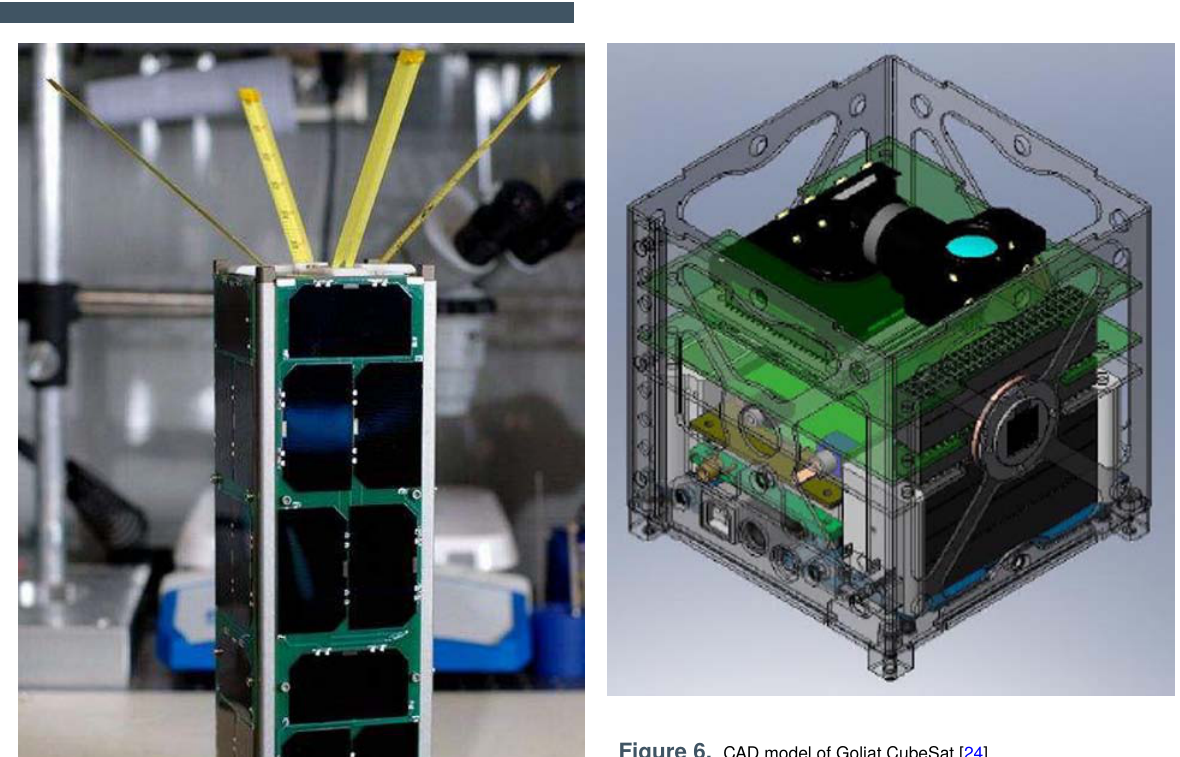
Figure 6. CAD model of Goliat CubeSat